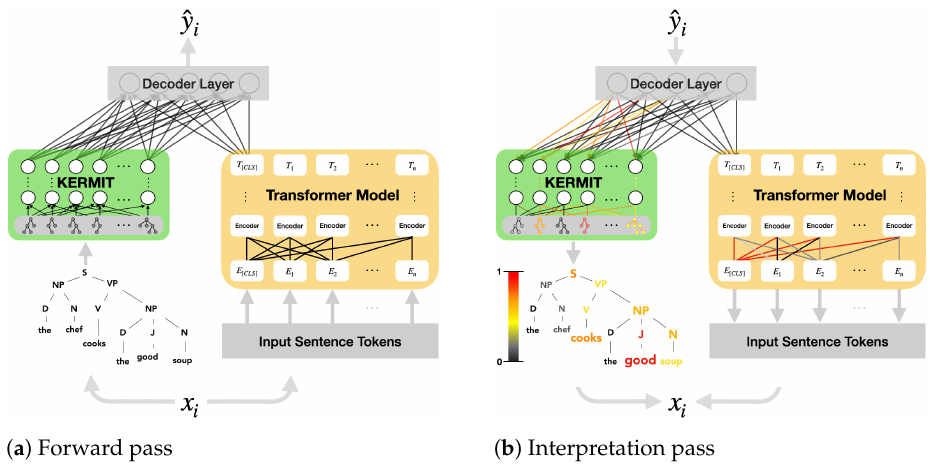
Figure 1. The KERMIT (cid:46)(cid:47) Transformers architecture. During the interpretation pass KERMIT viz is used to produce heat parse trees , while a transformer’s activation visualizer is used for the remainder of the